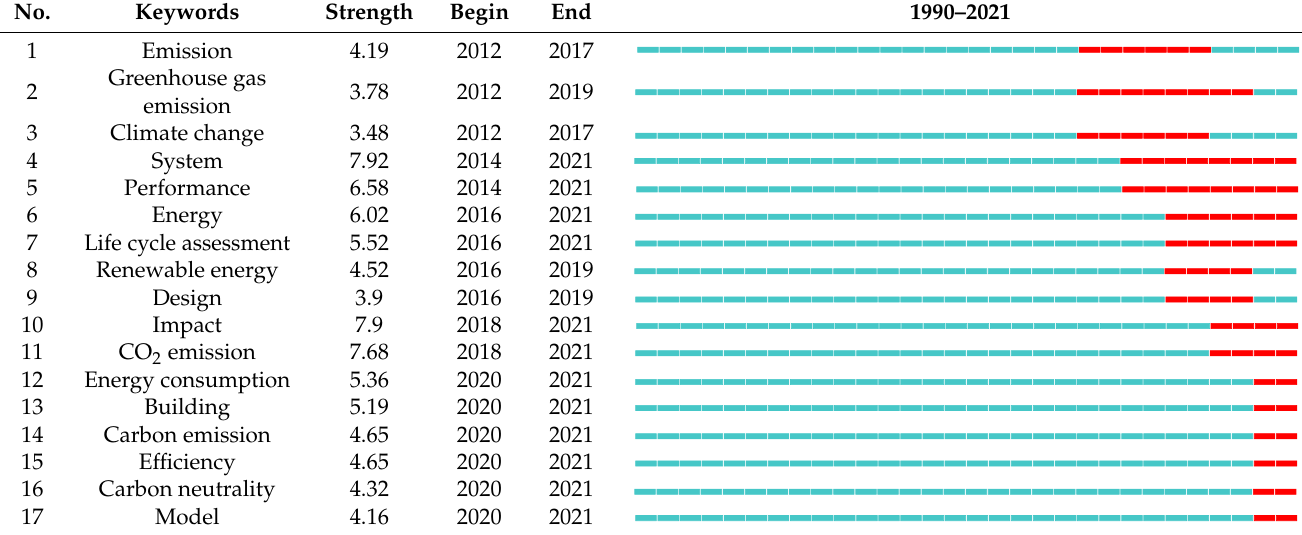
Table 6 lists the top 17 keywords with the strongest co-occurrence bursts (Red line segment represents the year of co-occurrence bursts), among which ‘System’,